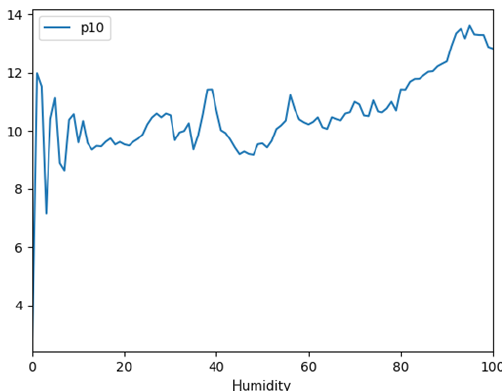
Figure 13. Architecture of the ontological population